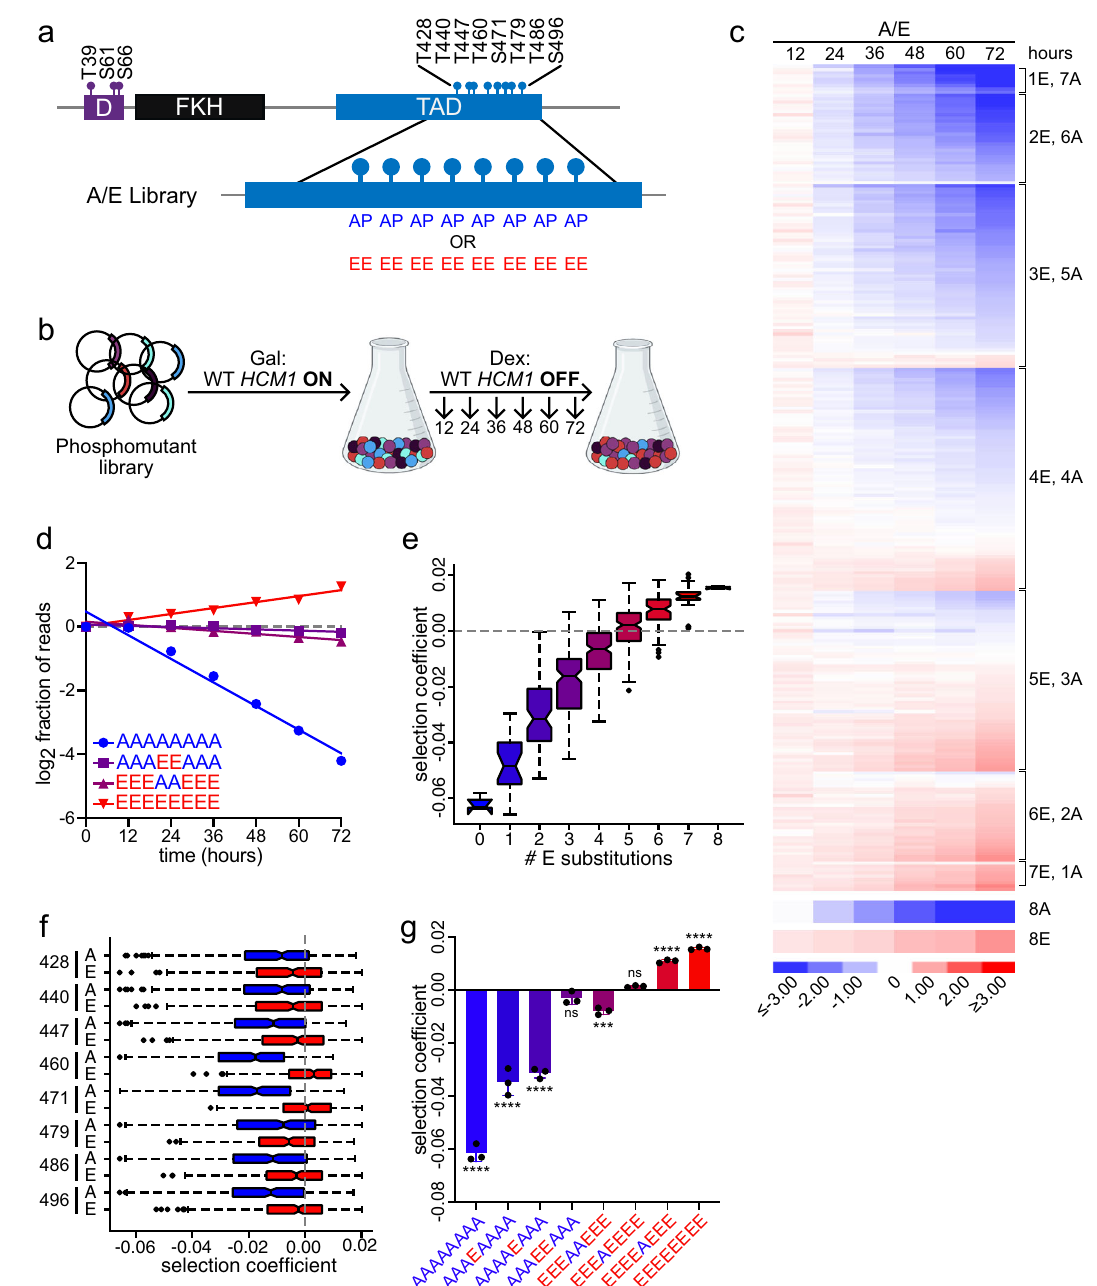
Fig. 2 | Decoding Hcm1 phosphoregulation with Phosphosite Scanning. a Schematic of phosphomutant library design. Each S/T-P site within the TAD was mutated to either unphosphorylatable A-P or phosphomimetic E-E in all 256 pos- sible combinations. b Schematic of the Phosphosite Scanning approach, see text for details. Created with Biorender.com. c Results from the A/E Phosphosite Scanning screen. Each row represents a mutant, shown is the log2 fold change in normalizedreadcountswithrespecttotimezeroforeachmutant,allmutantshave beennormalizedtoWT.Blueindicatesdepletion,redindicatesenrichment.Shown isanaverageof n =3biologicalreplicates.SeeSupplementaryFigs.2b – dand3afor additional analyses and correlation between replicates. d Graph of select mutants from( c ).Foreachmutant,thelog2fractionofnormalizedreads,normalizedtoWT, is plotted over time. The slope of a linear regression represents the selection coef fi cient (SC). Data points are an average of n =3 biological replicates. e , f Box and whisker plots showing the selection coef fi cients of groups ofmutants with the